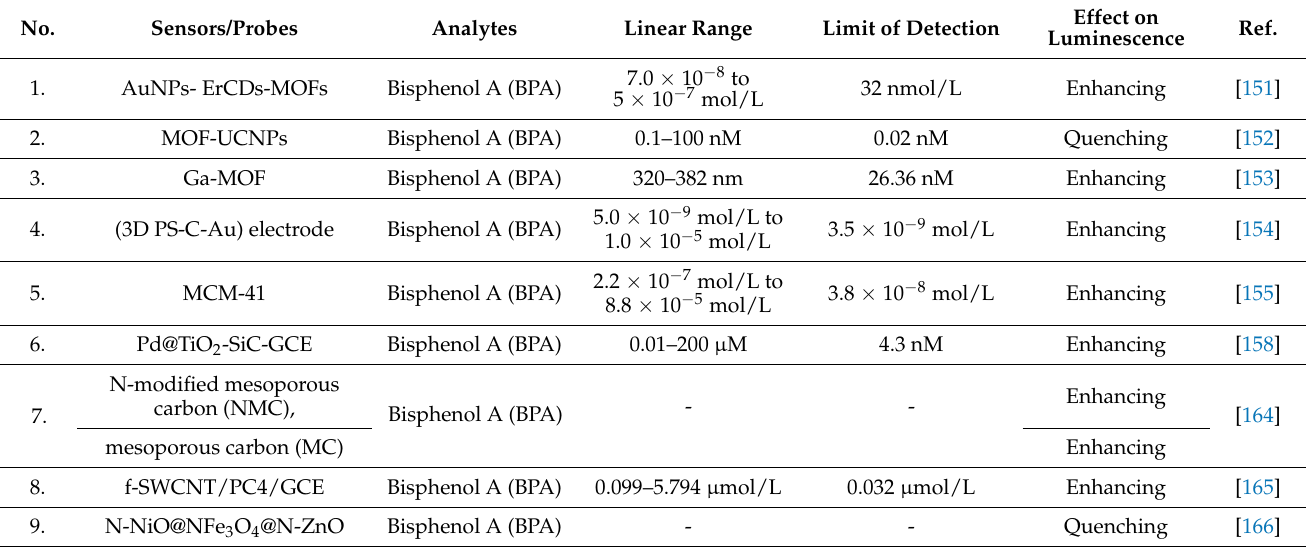
Table 3. Summary of various sensors/probes used for the detection of bisphenol A as a harmful